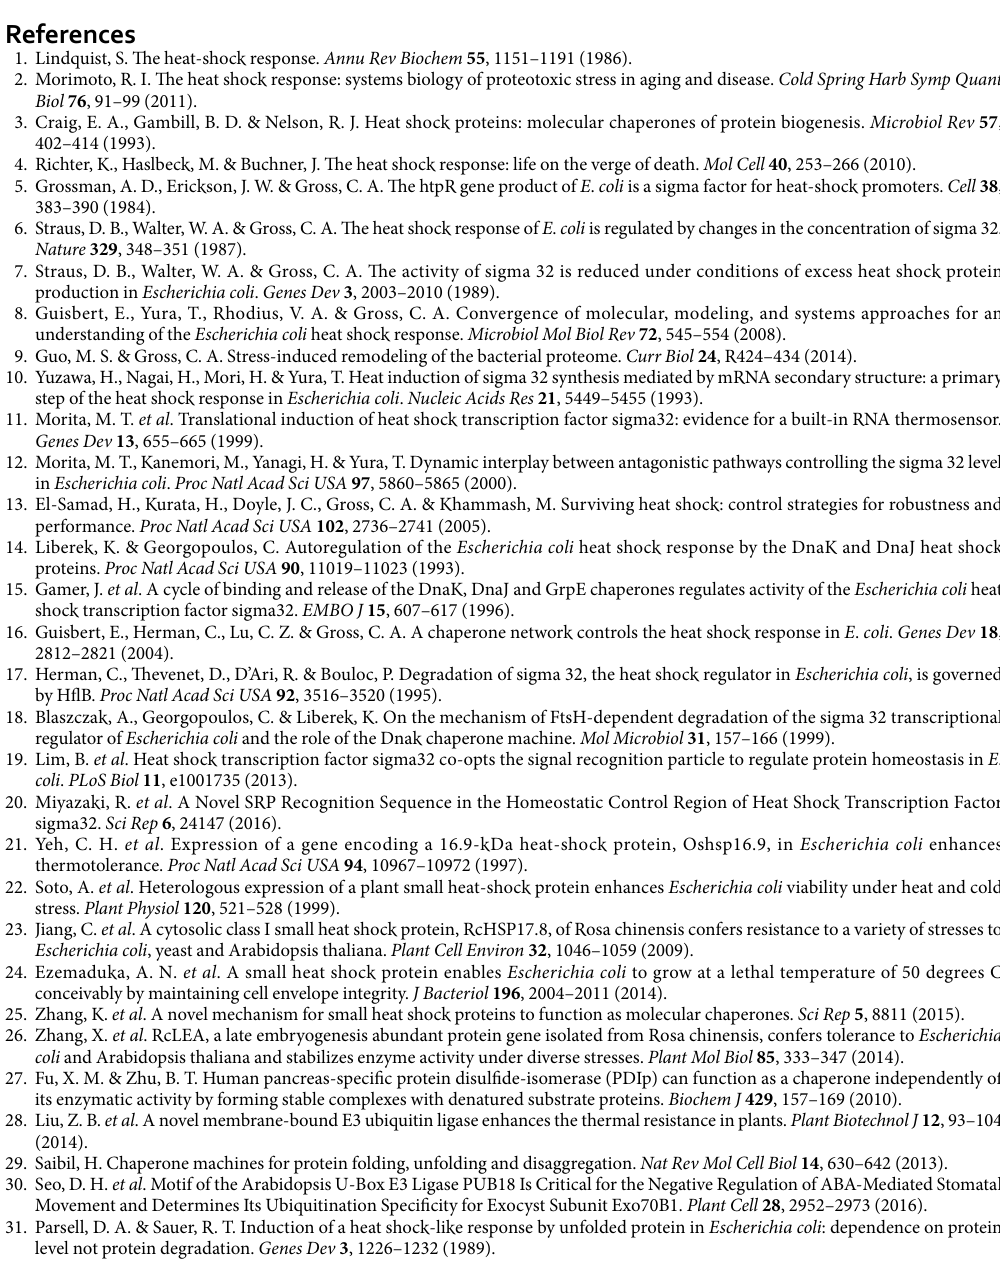
Table S6). The intersection of DEGs identified using the five methods were considered to be significantly up- or down-regulated in BnTR1 strains at 37 °C and 42 °C, respectively. The σ 32 regulons were summarized from Nonaka et al . 50